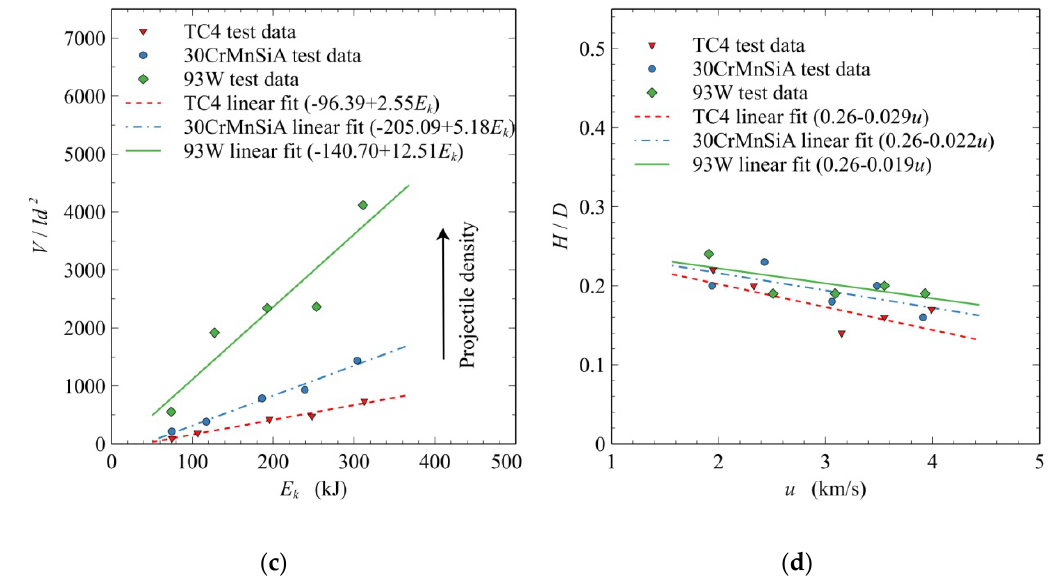
Figure 10. The influences of the impact velocity on crater depth, diameter, volume, and crater H / D ratio: ( a ) dimensionless crater depth versus impact velocity; ( b ) dimensionless crater diameter versus impact velocity; ( c ) dimensionless crater volume versus impact kinetic energy; ( d ) crater H / D ratio versus impact velocity.